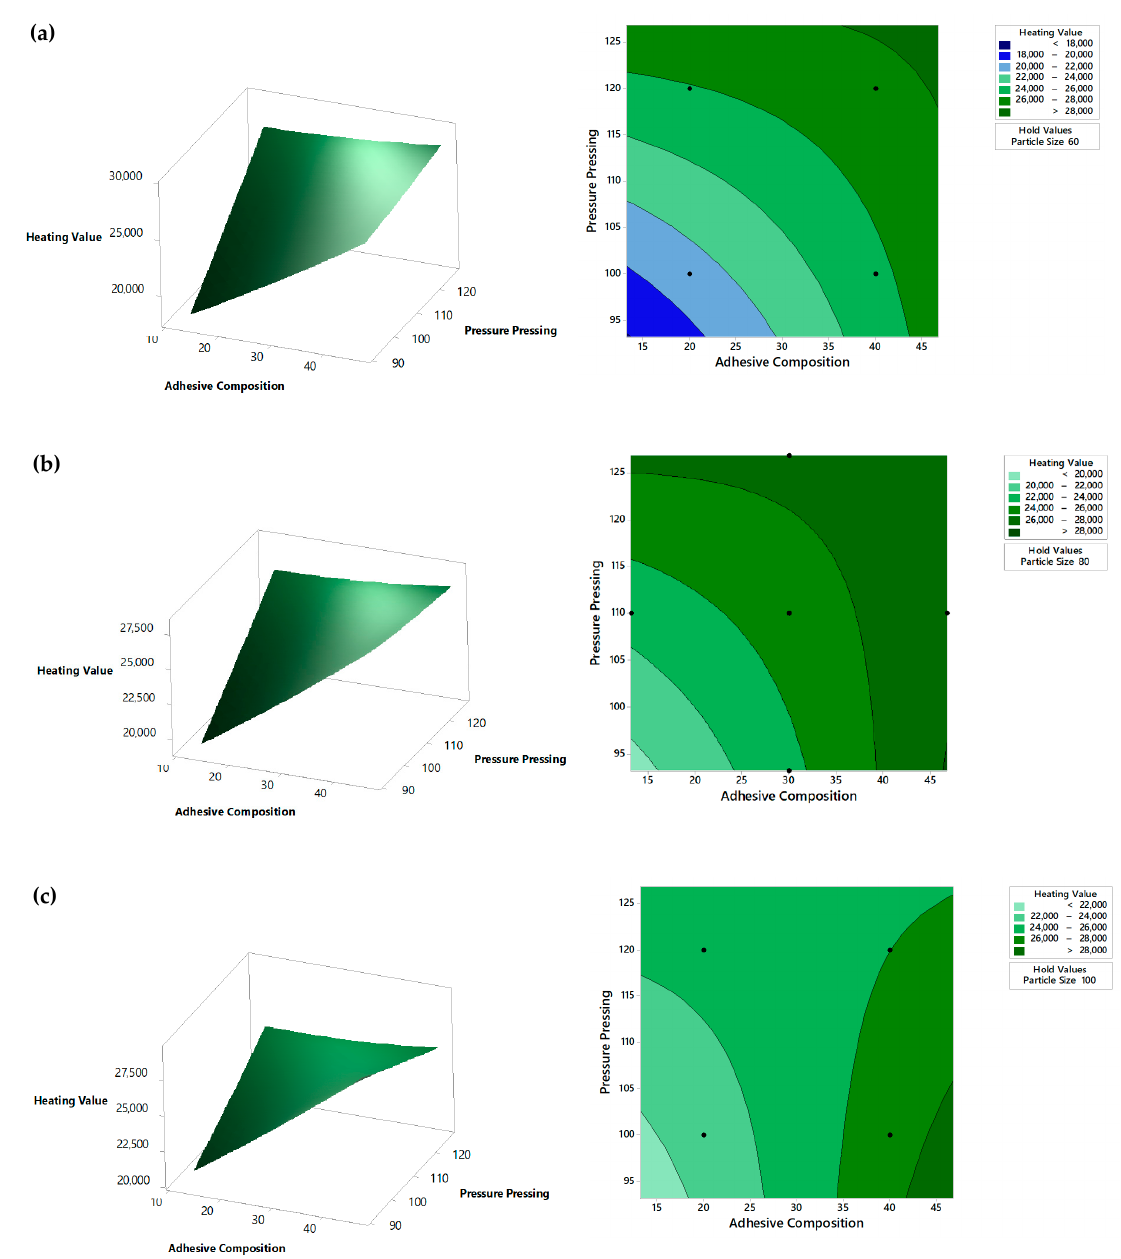
Figure 5. Graphic and contour of surface response of the adhesive composition and pressing pressure effect on the heating value of particle size ( a ) 60 ( b ) 80, and ( c ) 100 mesh.